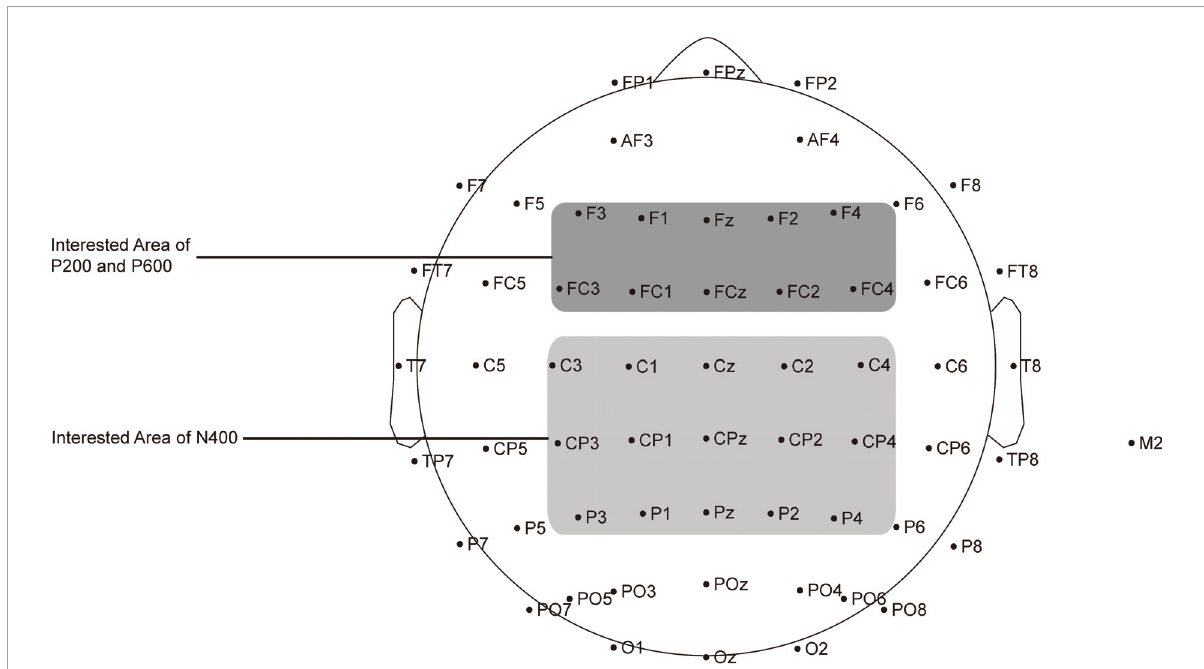
FIGURE3 Distribution of the 64 electrodes over the scalp used to record EEG signals. The electrodes used to capture P200 and P600 are marked in dark gray, and those used to capture N400 are marked in light